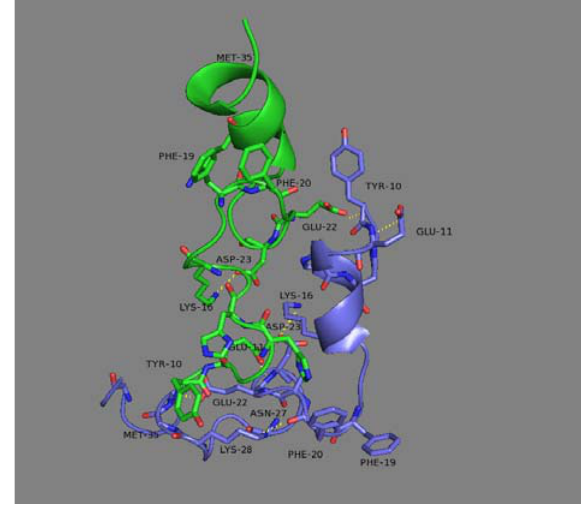
Figure 2. Geometric evolution of both monomers within the dimer structure. Monomer A (in blue) and monomer B (in green) at C1 (2.80 ns, between stage I and stage II) and at C3 (11.7 ns, at then end of stage III). The side-chains at the dimer interface are depicted explicitly.